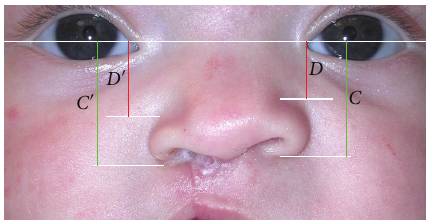
Figure 2: The distances between the nasal base and top of alar groove to the line intersecting medial ocular angles between sides were assessed. The ratio of the height of the alar groove = the ratio of the height of the top of the alar groove on the cleft side ( D (cid:3) / C (cid:3) )/the ratio of the height of the top of the alar groove on the noncleft side ( D / C